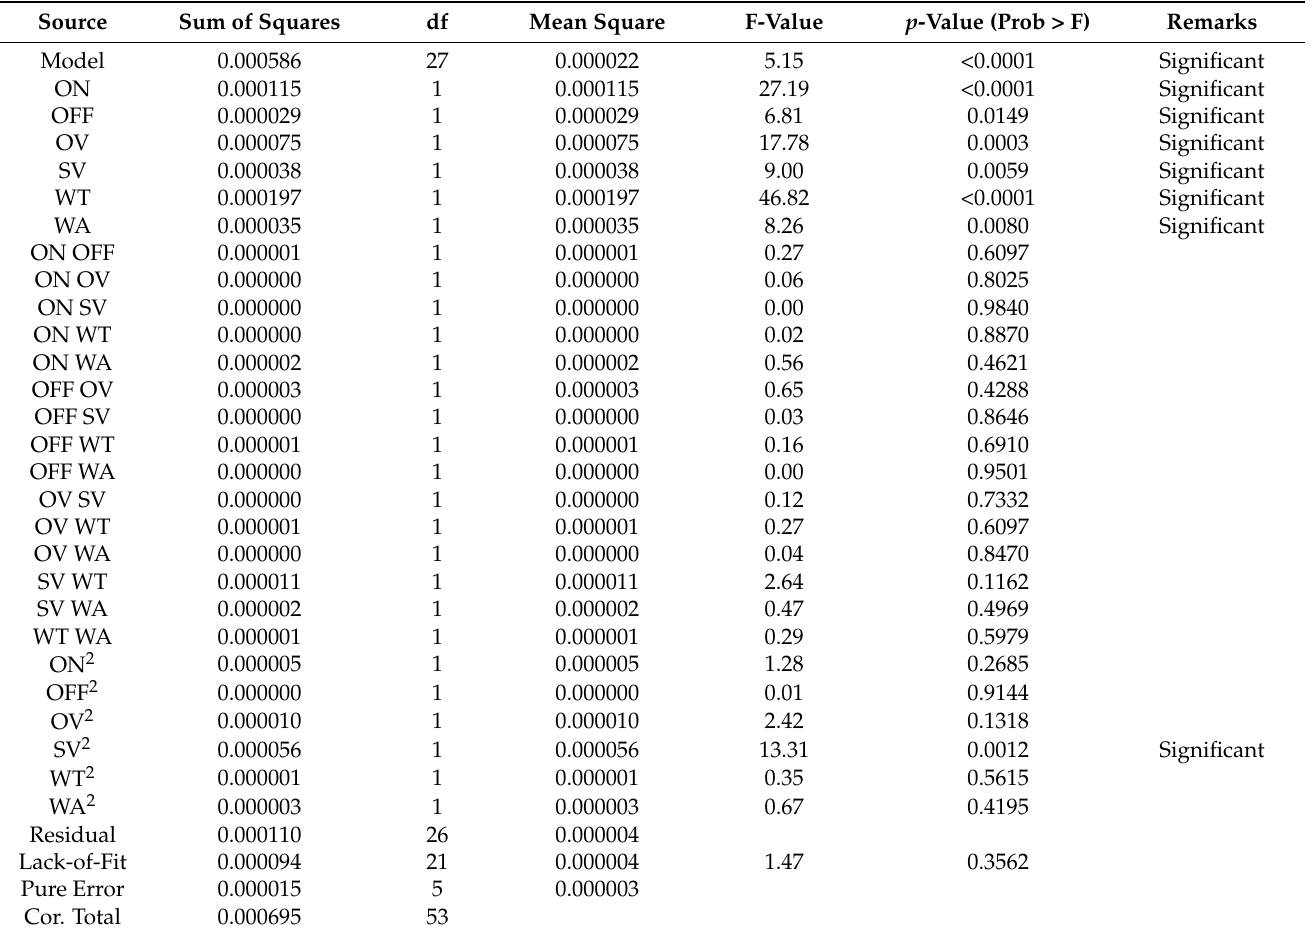
Table 5. ANOVA results of quadratic response surface model for 90 ◦ corner.